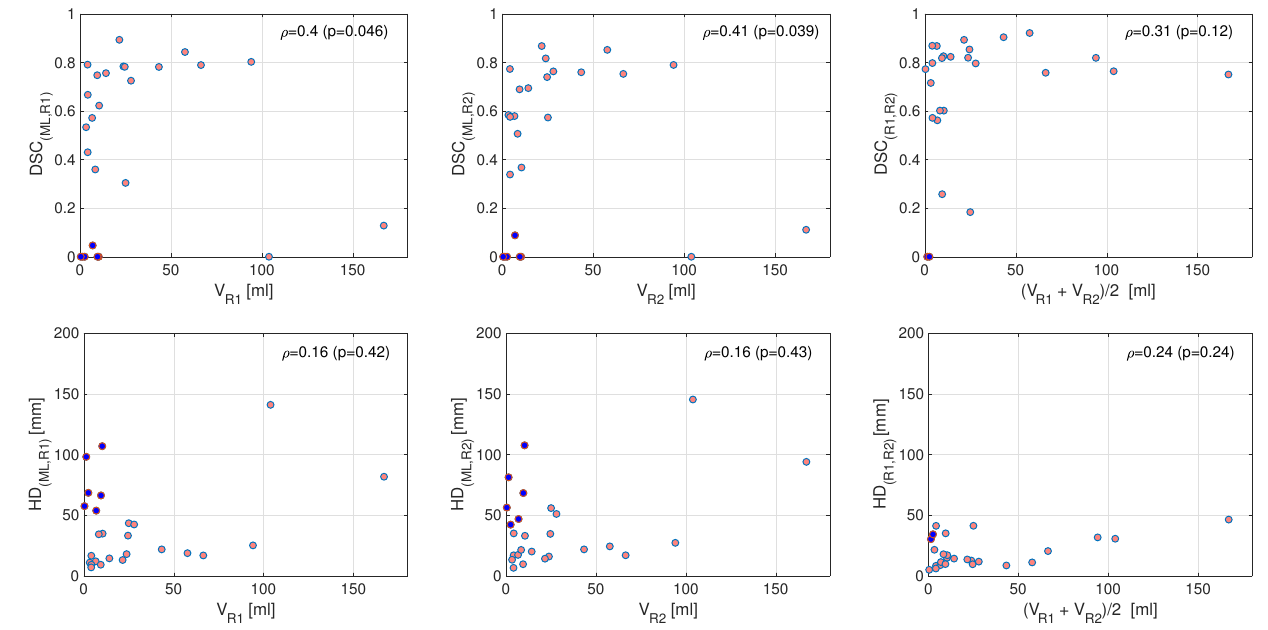
Figure 7. Tumor volume in relation to segmentation performance. ( Left ): R1 tumor volume. ( Middle ): R2 tumor volume. ( Right ): Mean tumor volume for R1- and R2 masks. ( Upper row ): Tumor volume against Dice coefficient (DSC). There is a weak but significant correlation between primary tumor volume and DSC for DL (deep learning)-R1/R2 (left and middle panel, p ≤ 0.046). R1-R2 DSC only tended to be associated with tumor volume (right panel, p = 0.12). ( Lower row ): Plots of tumor volume against Hausdorff distance (HD). We found no significant correlation between primary tumor volume and HD for any of the associations DL-R1/R2 or R1-R2 ( p ≥ 0.24). Both rows: The same patients with (i) low DSC < 0.2 and (ii) a small tumor volume < 50 mL (estimated tumor volume for this condition is either R1 (left), R2 (middle), or mean (R1, R2) tumor volume) are simultaneously marked in blue in upper and lower panels, suggesting that patients experiencing a low DSC are normally high in HD for ML-R1/R2 (left and middle panels, the same n = 6 patients were identified). For R1-R2, patients with low DSC also have low HD (right panel, n = 2 patients). R1 = rater 1; R2 = rater 2; V = tumor volume, { ρ , p } = Spearman rank correlation coefficient with associated p -value.